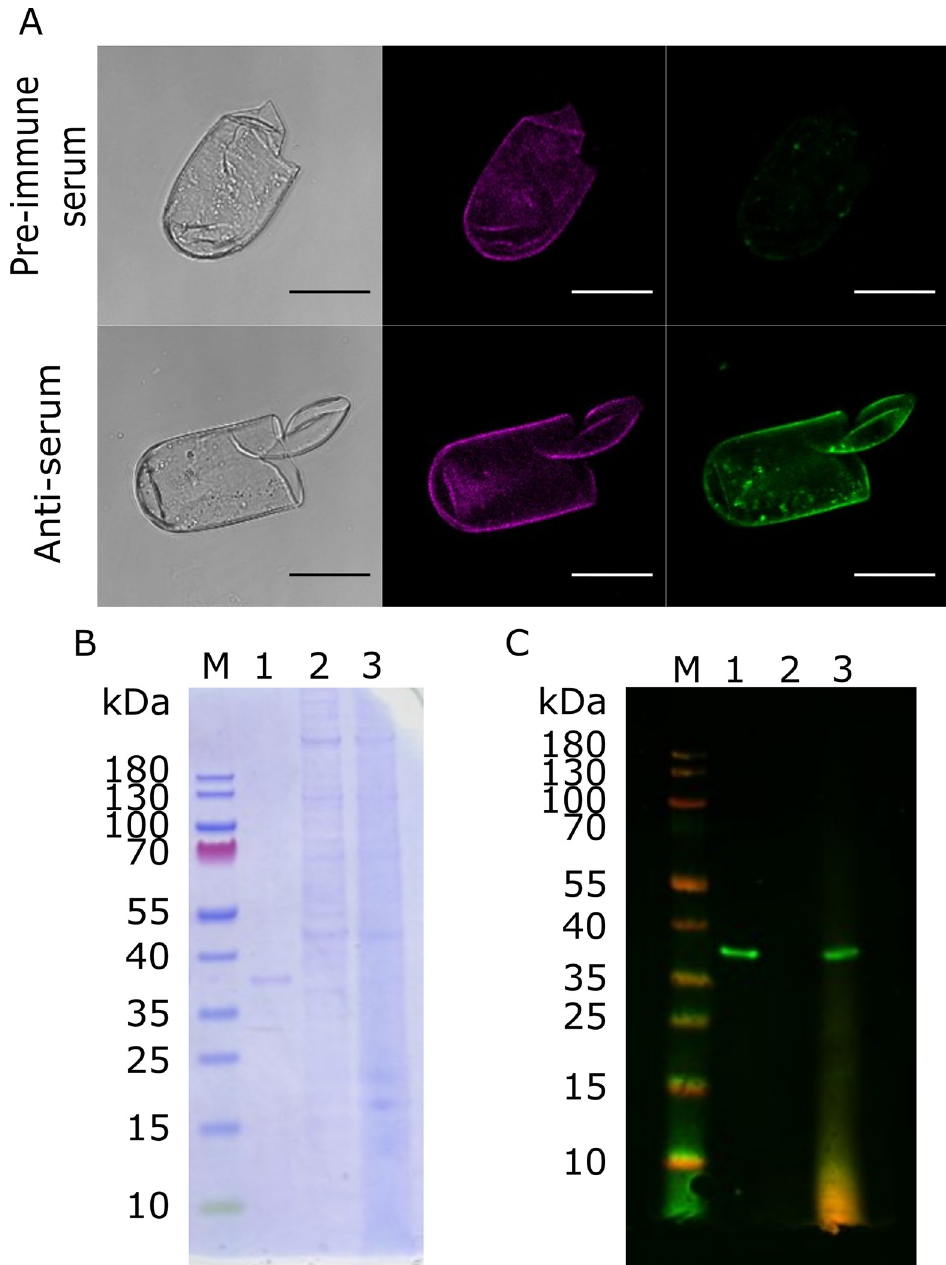
Fig 2. Annexin Localisation. A) Binding of antiserum raised against immunogenic, unique, peptides from GROS_g03104 on G . rostochiensis eggshell. Weak fluorescence can be seen in eggshells when imaging pre-immune serum samples due to native eggshell autofluorescence. Images left to right; DIC, laser line 516 nm, laser line 488 nm. Scale bar represents 50 μ m. B) SDS-PAGE stained with coomassie. Samples are M–Marker (PageRuler Prestained Protein Ladder); 1 – 100ng recombinant annexin; 2—Juvenile (J2) G . rostochiensis lysate from (~20,000 J2s); 3 – G . rostochiensis cyst lysate (containing eggshells and juveniles, 30 cysts). C) Western blot for (B) with same sample layout. Primary antibody 1:5000 A1, secondary antibody 1:20000 Invitrogen Goat anti-Rabbit IgG Alexa Fluor Plus 800. GROS_g03104 antiserum binds to annexin only when eggshells are present, confirming specificity.